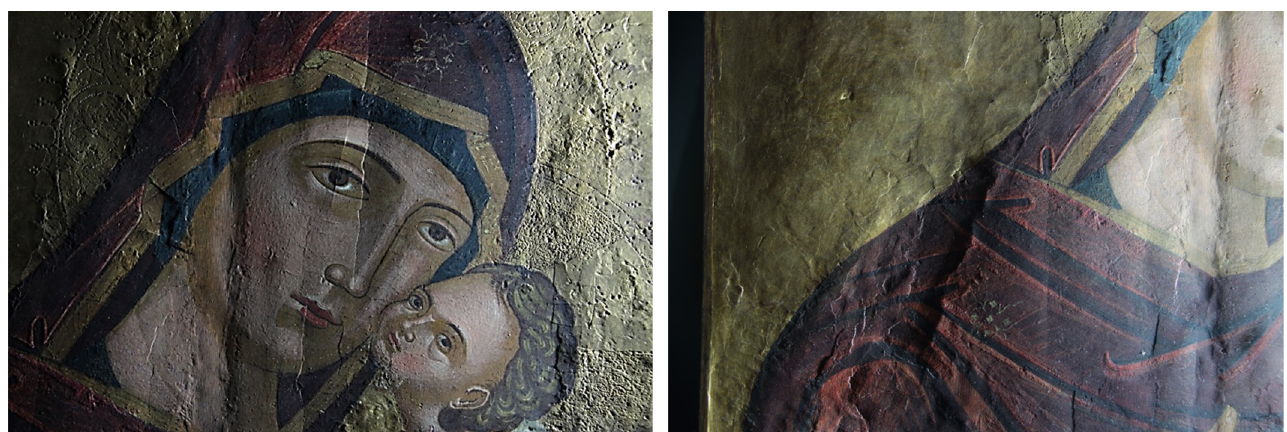
Figure 2. Vis: Detail, feet of the Child Jesus in which the colors overlap, the mission gilding, and a retouching are observed ( left ); face of the Child Jesus ( right up ); face of the Madonna, chromatic integration ( right down ).